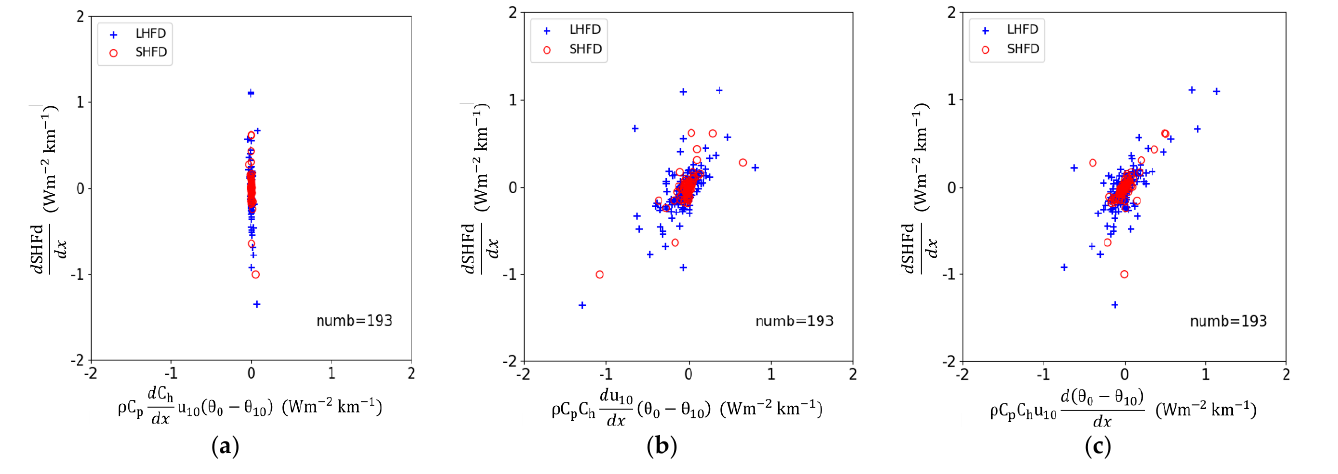
Figure 8. Contribution of spatial variation of bulk transfer coefficient C h (stability term), wind speed (dynamic term), △θ = 𝜃 0 − 𝜃 10 and △ Q = Q 0 –Q 10 (thermodynamic term) to the heat fluxes variation. ( a ) stability term; ( b ) dynamic term; ( c ) thermodynamic term.